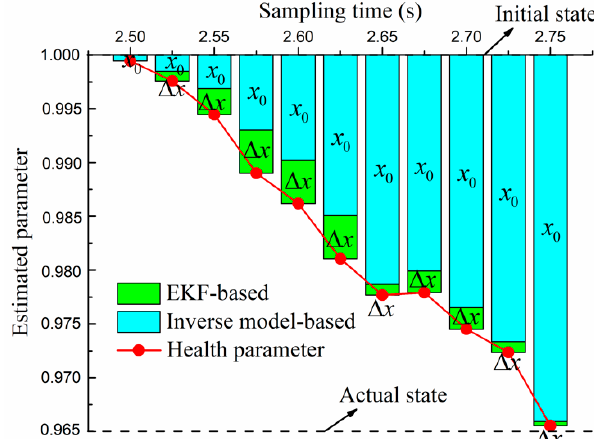
Figure 14. The local analysis of SW1 in Case 1.